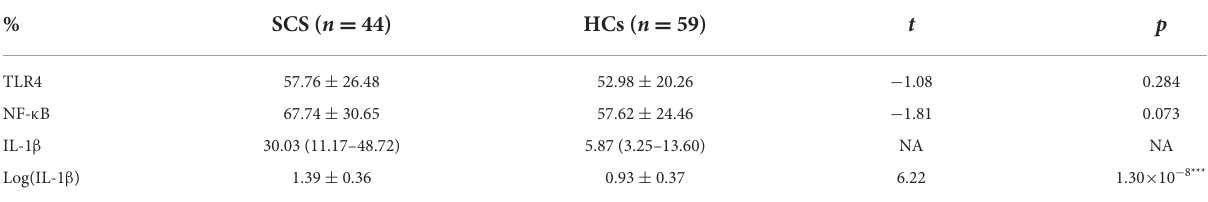
TABLE 2 The comparison of TLR4 signaling pathway activity in schizophrenia patients and controls.